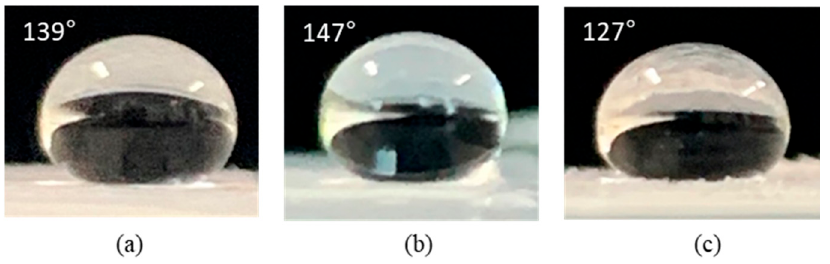
Figure 7. Photographs of water droplets on silica aerogel powders prepared with water glass solution concentrations of ( a ) 5.7%; ( b ) 6.6%; ( c ) 8.7%.